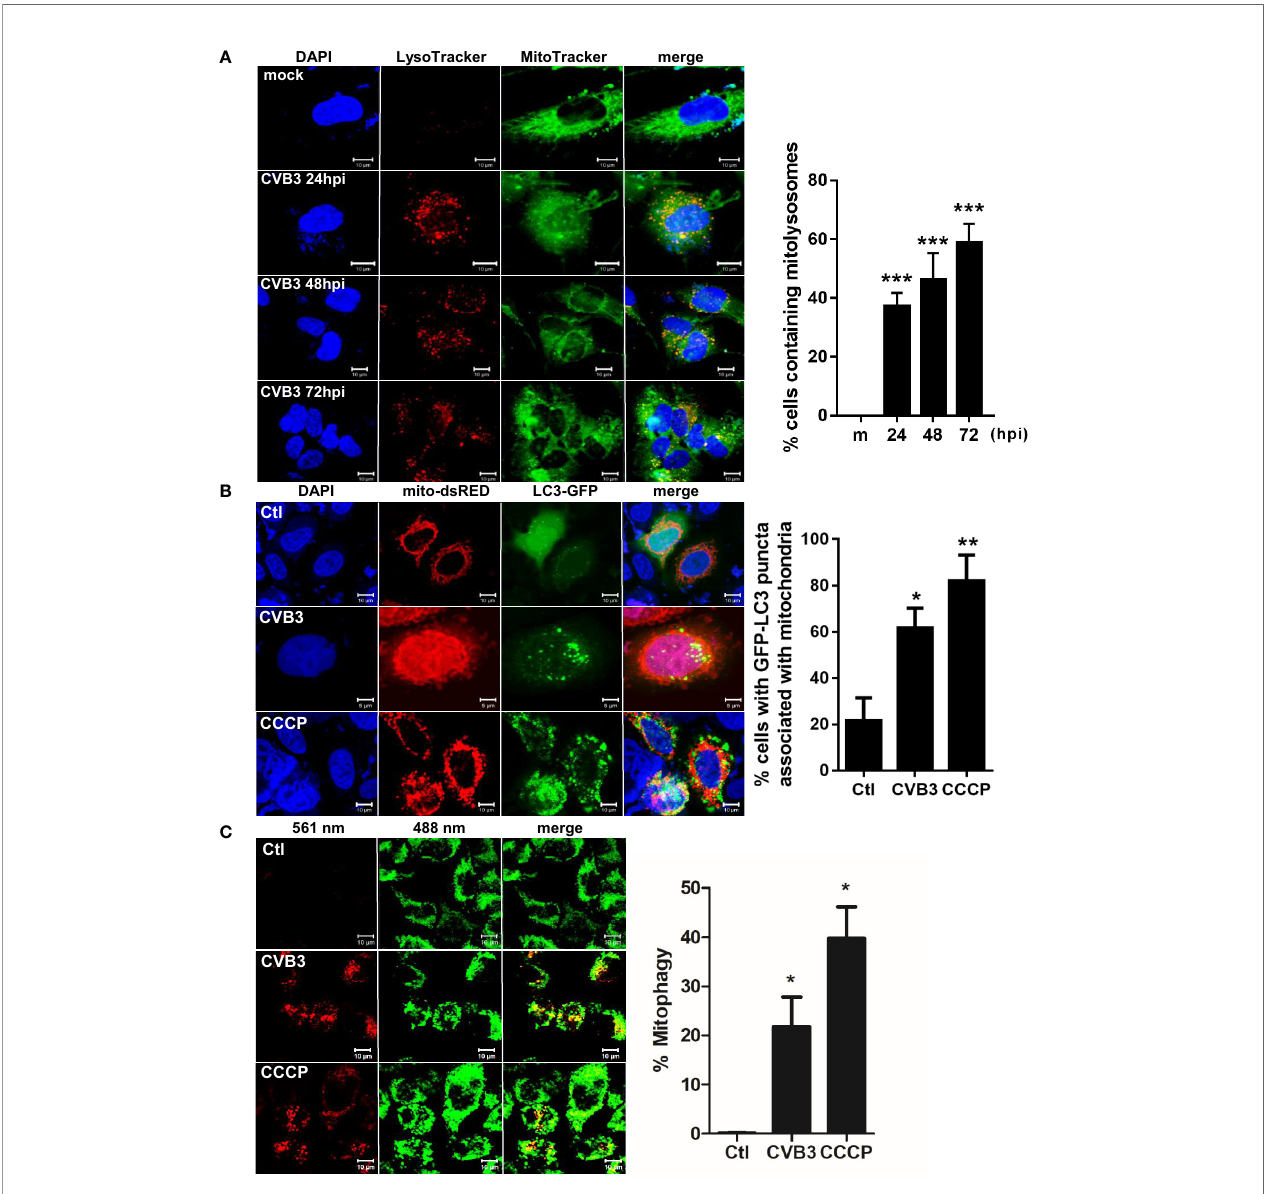
FIGURE 2 | Induction of mitophagy following CVB3 infection. (A) hNPCs were infected with mock (m) or CVB3 at an MOI of 5 for the indicated time points. The cells were subsequently stained with MitoTracker Green and LysoTracker Red. Scale bar=10 m m. Percentage (%) of cells containing mitolysosomes is quanti fi ed and represented as a graph on the right. At least 100 cells were counted per experiment (n=3) (B) HeLa-Parkin cells were transfected with LC3-GFP (green) and mito- dsRED (red) plasmids and infected with CVB3 for 8 h or treated with control DMSO (Ctl) CCCP for 2 h. Scale bar=10 m m. Percentage (%) of cells with LC3 puncta associated with mitochondria is quanti fi ed and represented as a graph on the right. (C) HeLa-Parkin cells expressing mt-Keima were either treated with 25 m M CCCP for 2 h or infected with CVB3 for 8 h. The emission signal obtained after excitation with the 488 nm laser is shown in green, and that obtained after excitation with the 561 nm laser is shown in red. Zeiss ZEN software was used to determine changes in pH-dependent fl uorescence and % mitophagy is represented in graph. Scale bar =10 m m. Bar graph shows mean ± SD from at least 100 cells/condition compiled from three experiments. *p < 0.05; **p < 0.01; ***p < 0.001 vs . control DMSO-treated